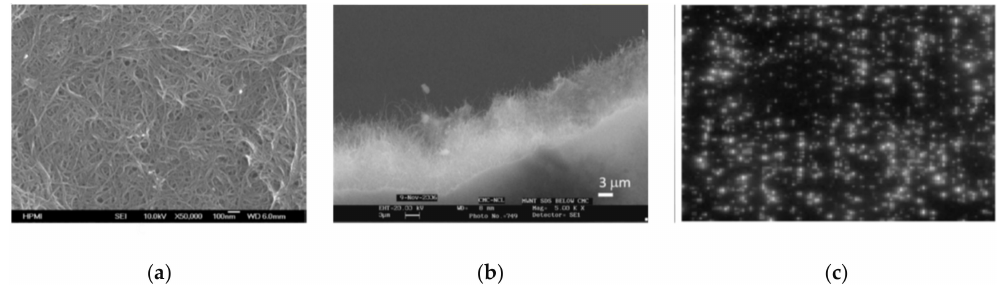
Figure 5. Uniform and large area FE cathodes: ( a , b ) SEM images of the buckypaper surface reprinted with permission from [101] ( a ) and reprinted with permission from [102] ( b ); ( c ) the emission image of the screen-printed FED (reprinted with permission from [104]).